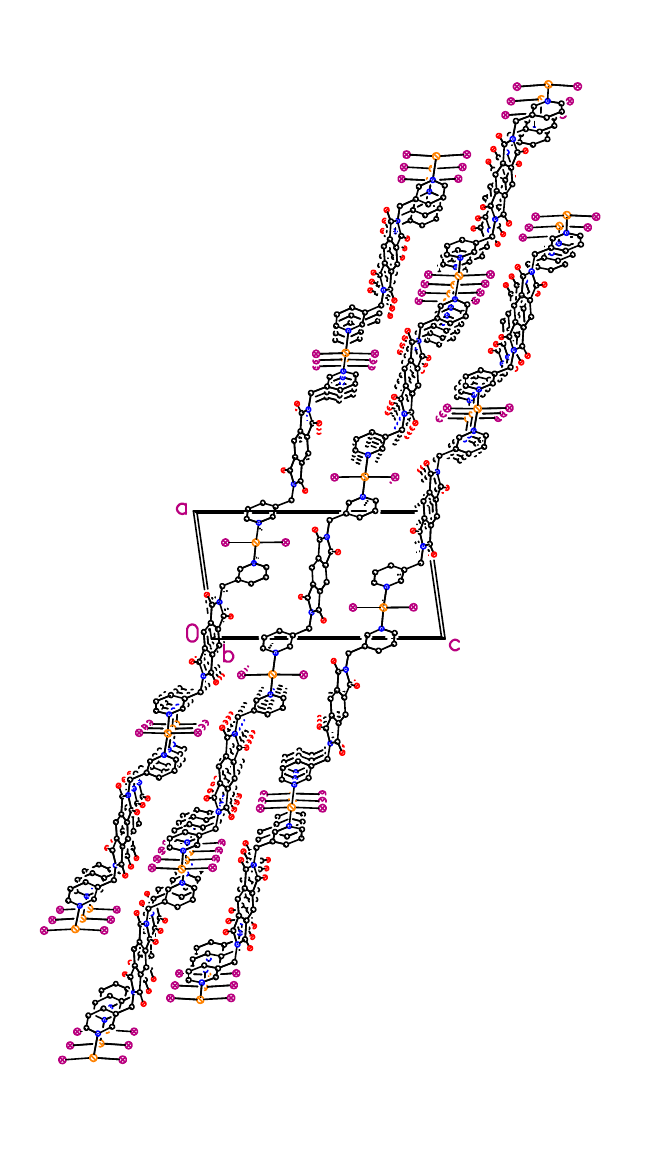
Figure 6. The zigzag polymer chain in complex 2 . H atoms and solvent molecule are omitted for